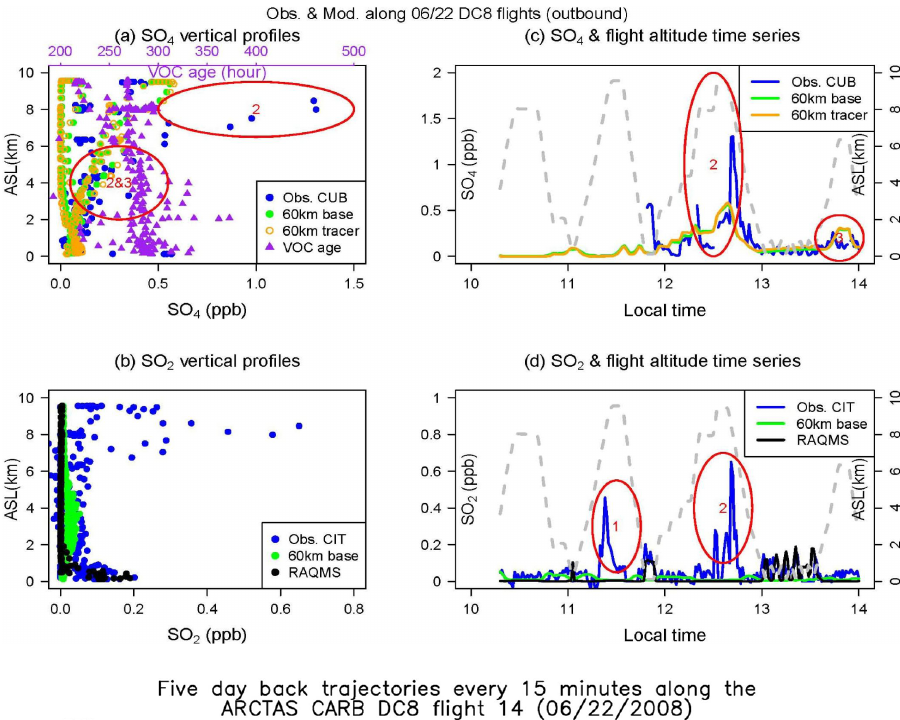
Atmos. Chem. Phys., 11, 3173–3194, 2011